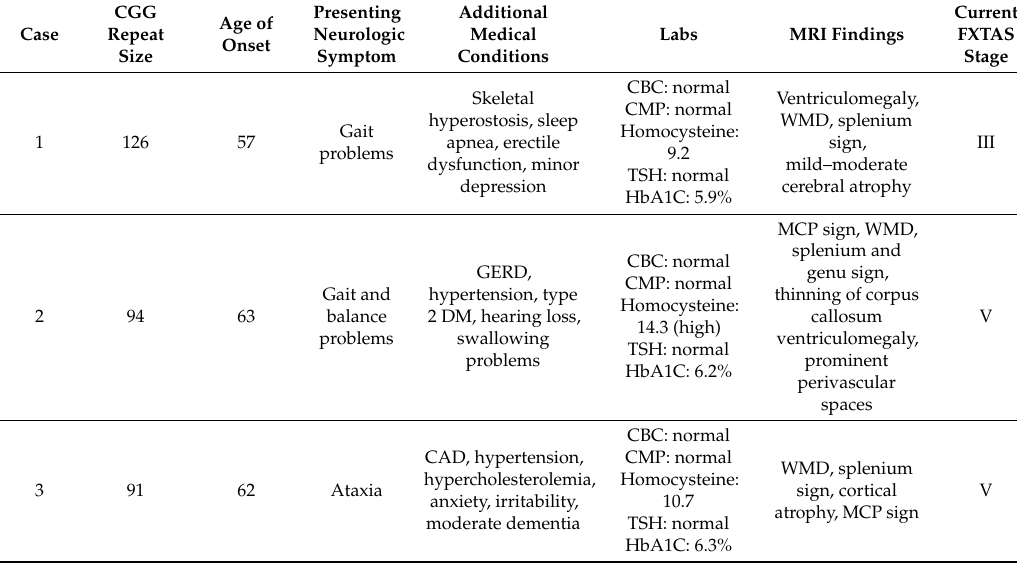
Table 1. Summary of case